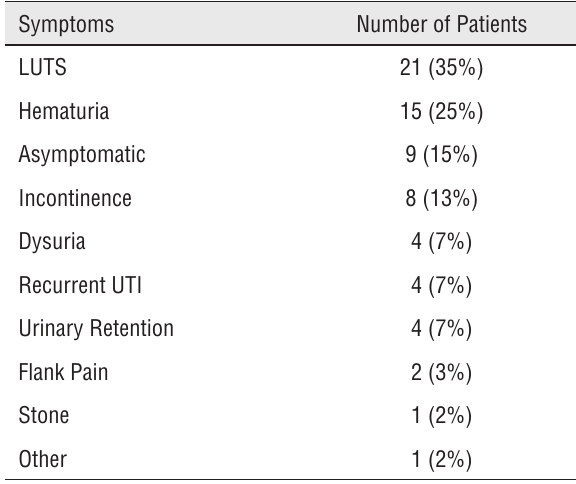
Table 2 - presenting Symptoms prior to